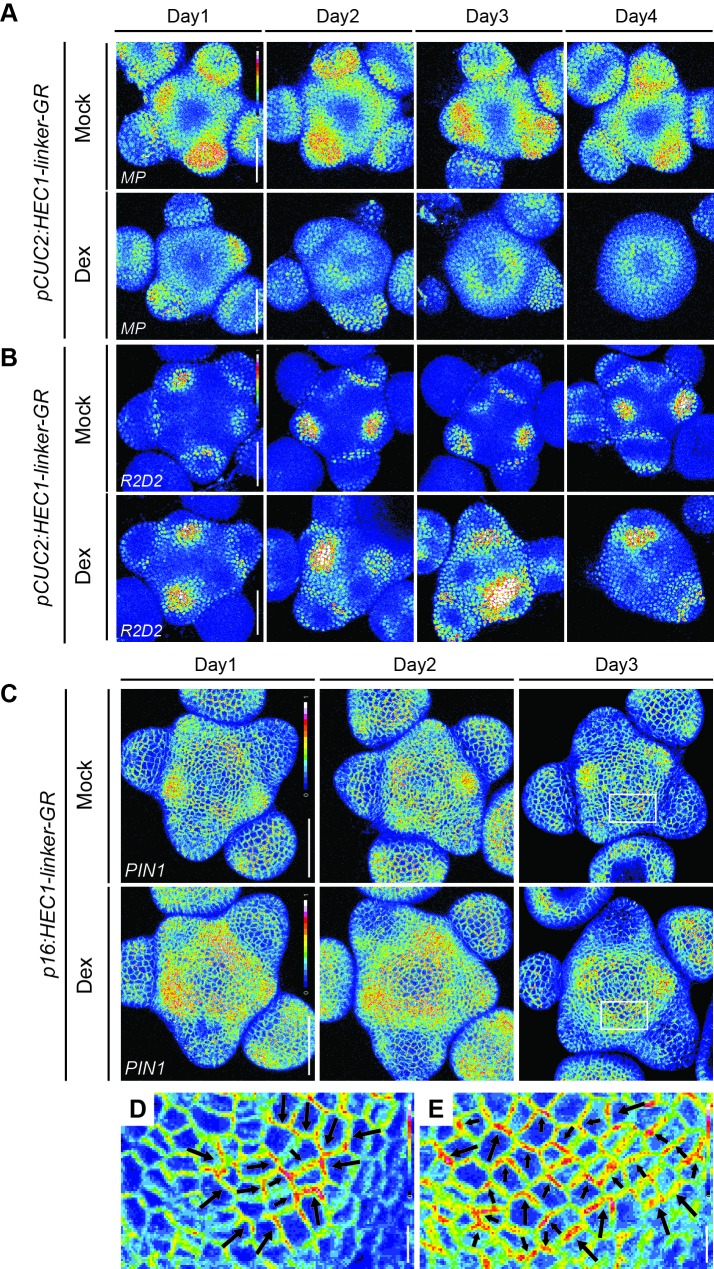
Dynamics of MP-GFP, PIN1-GFP and R2D2 after HEC1-GR induction at the PZ/BZ.(A) Time series of pMP:MP-GFP in individual pCUC2:HEC1-linker-GR shoot meristems after mock or dex treatment (n > 6 per condition). (B) Time series of auxin signalling input in individual pCUC2:HEC1-linker-GR shoot meristems expressing R2D2 after mock or dex treatment. Higher R2D2 intensity signals mark low auxin sensing regions (n > 4 per condition). (C) Time series of pPIN1:PIN1-GFP in individual p16:HEC1-linker-GR shoot meristems after mock or dex treatment (mock: n > 4; dex: n > 9 per condition). (D–E) Magnified views of white boxes in (C) depicting pPIN1:PIN1-GFP after p16:HEC1-linker-GR mock (D) or dex (E) induction. Black arrows estimate PIN1 polarity. Scale bar: 50 µm (A–C), 5 µm (D–E).